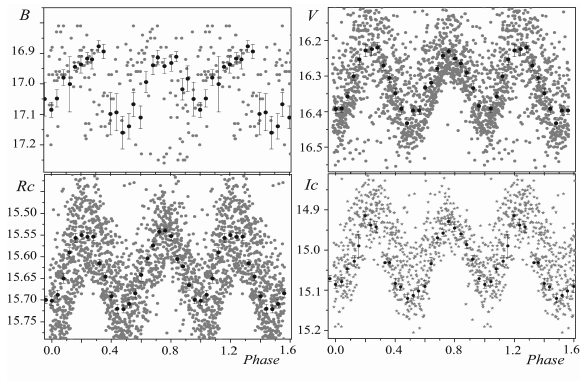
Figure 4: The average orbital phase BVR C I C LCs in 2006–2012, folded with ephemeris (1). Individual ob- servations are marked by grey points, mean values by black points.